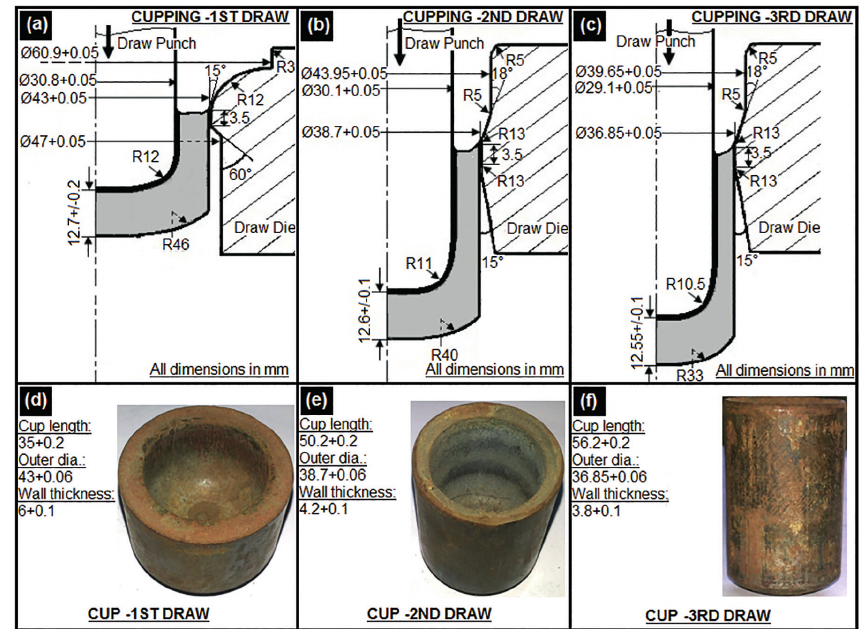
Figure 4: 3-stage cup drawing process, a-c) schematically showing of arrangements; d-f) photo images of drawn